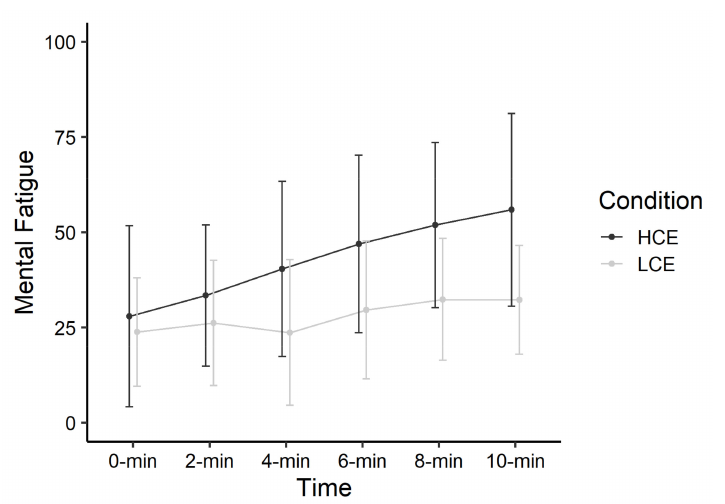
Figure 2. Mental fatigue during cognitive task manipulations, by condition. Data points represent means with standard deviation error bars. LCE = low cognitive exertion; HCE = high cognitive